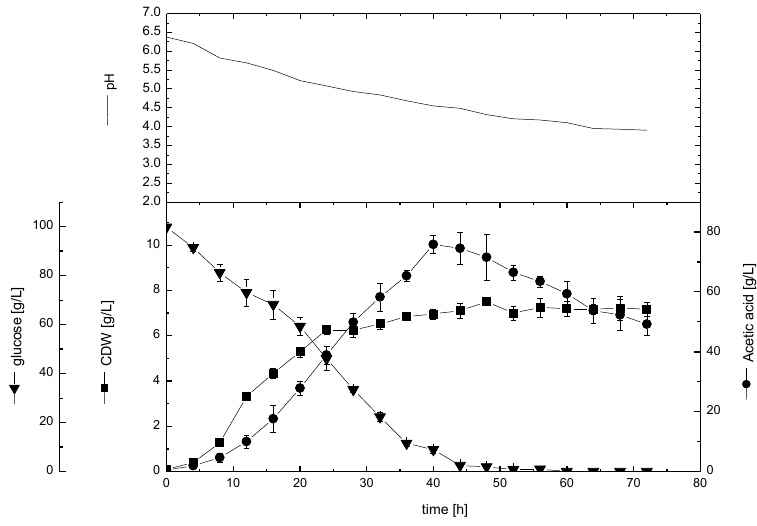
Figure 6. Batch cultivation for acetic acid production using bioreactor 16-L under un- controlled